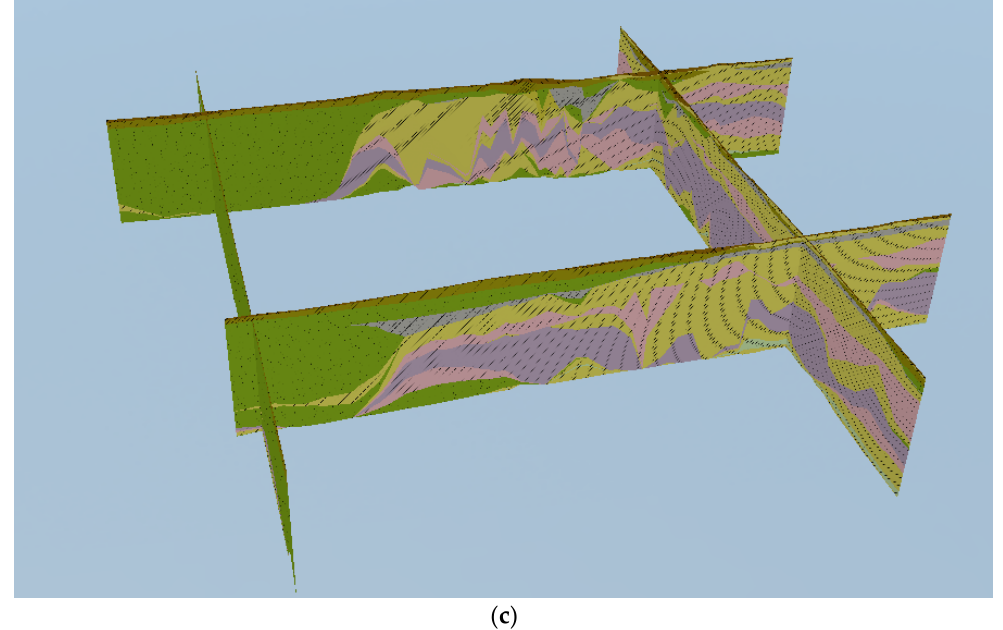
Figure 18. Grid map of geological transect and its location. ( a ) Location of four transect; ( b ) four geological transects north facing observation, ( c ) four geological transects west facing observation.